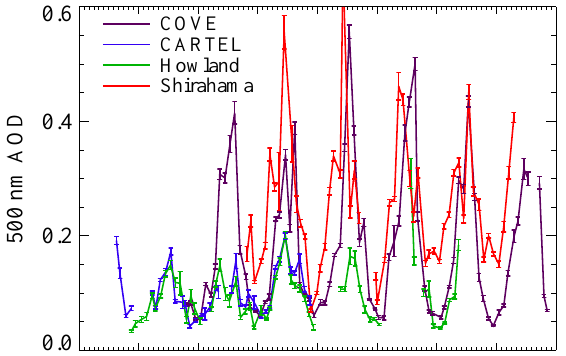
Fig. 12. Time-series of AOD from four AERONET sites along the eastern seaboards of North America (COVE, CARTEL and How- land) and Northern Asia Fig.12. Time-series of AODfrom four AERONETsitesalong the eastern seaboards of North America (COVE, CARTEL and Howland) and Northern Asia (Shirahama).